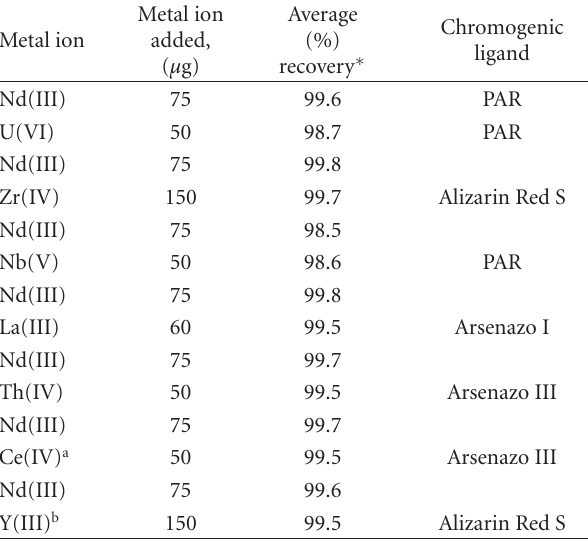
Masked with 10mg fluoride, b masked with 50mg thiosulphate, and ∗ average of six determinations.